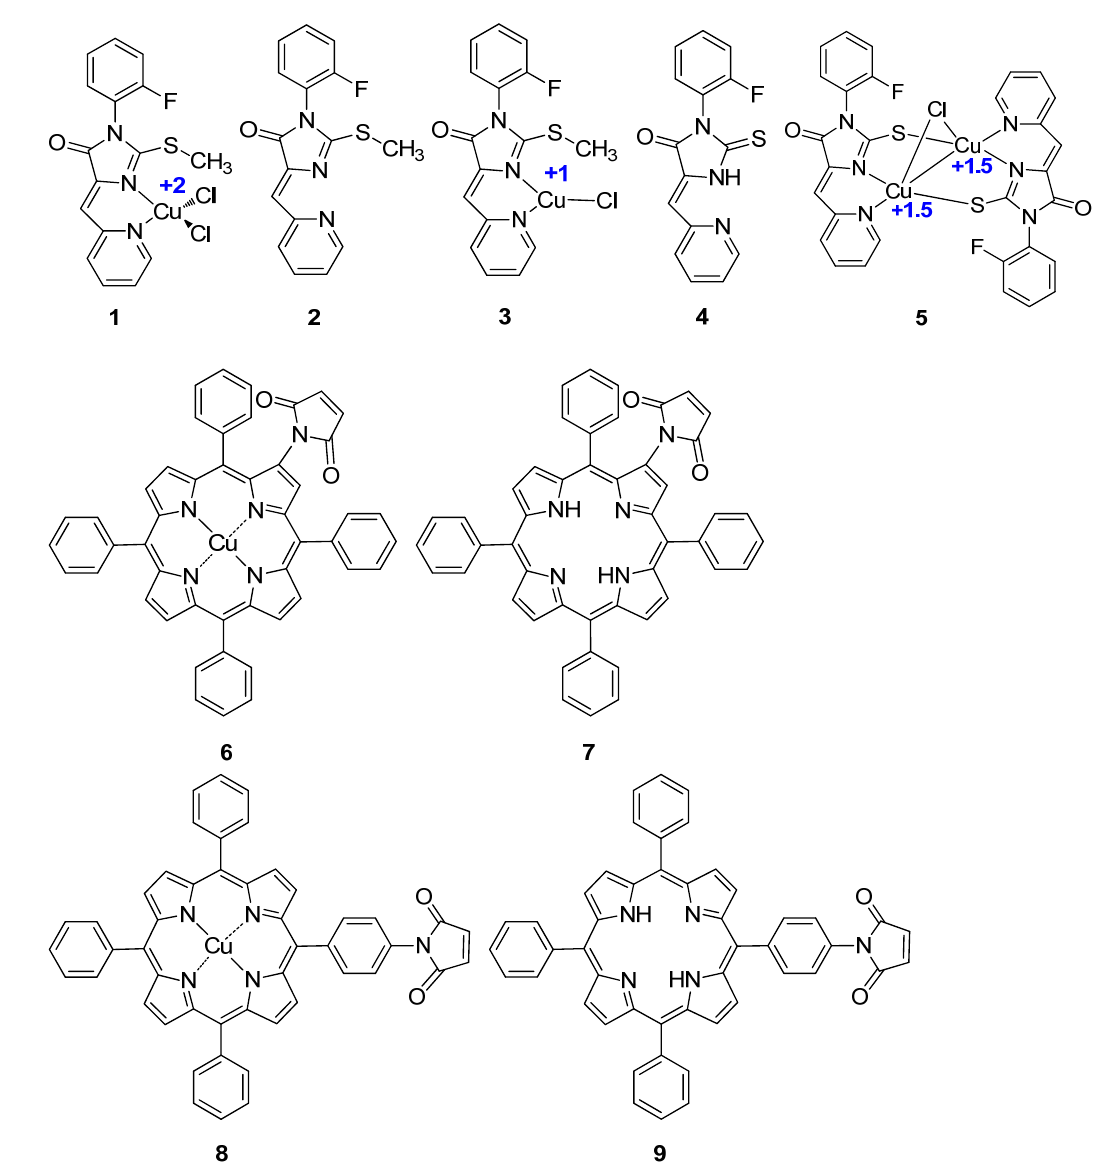
Scheme 1. Structures of copper organic complexes and the respective metal-free ligands used in the study. These results strongly suggested that the context for the copper ion, particularly its